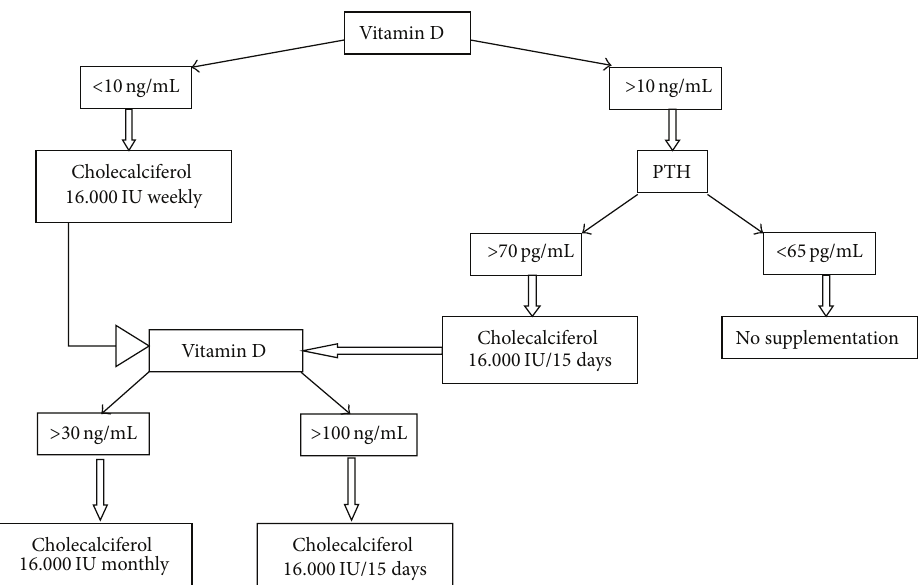
Figure 1: Protocol of vitamin D supplementation.